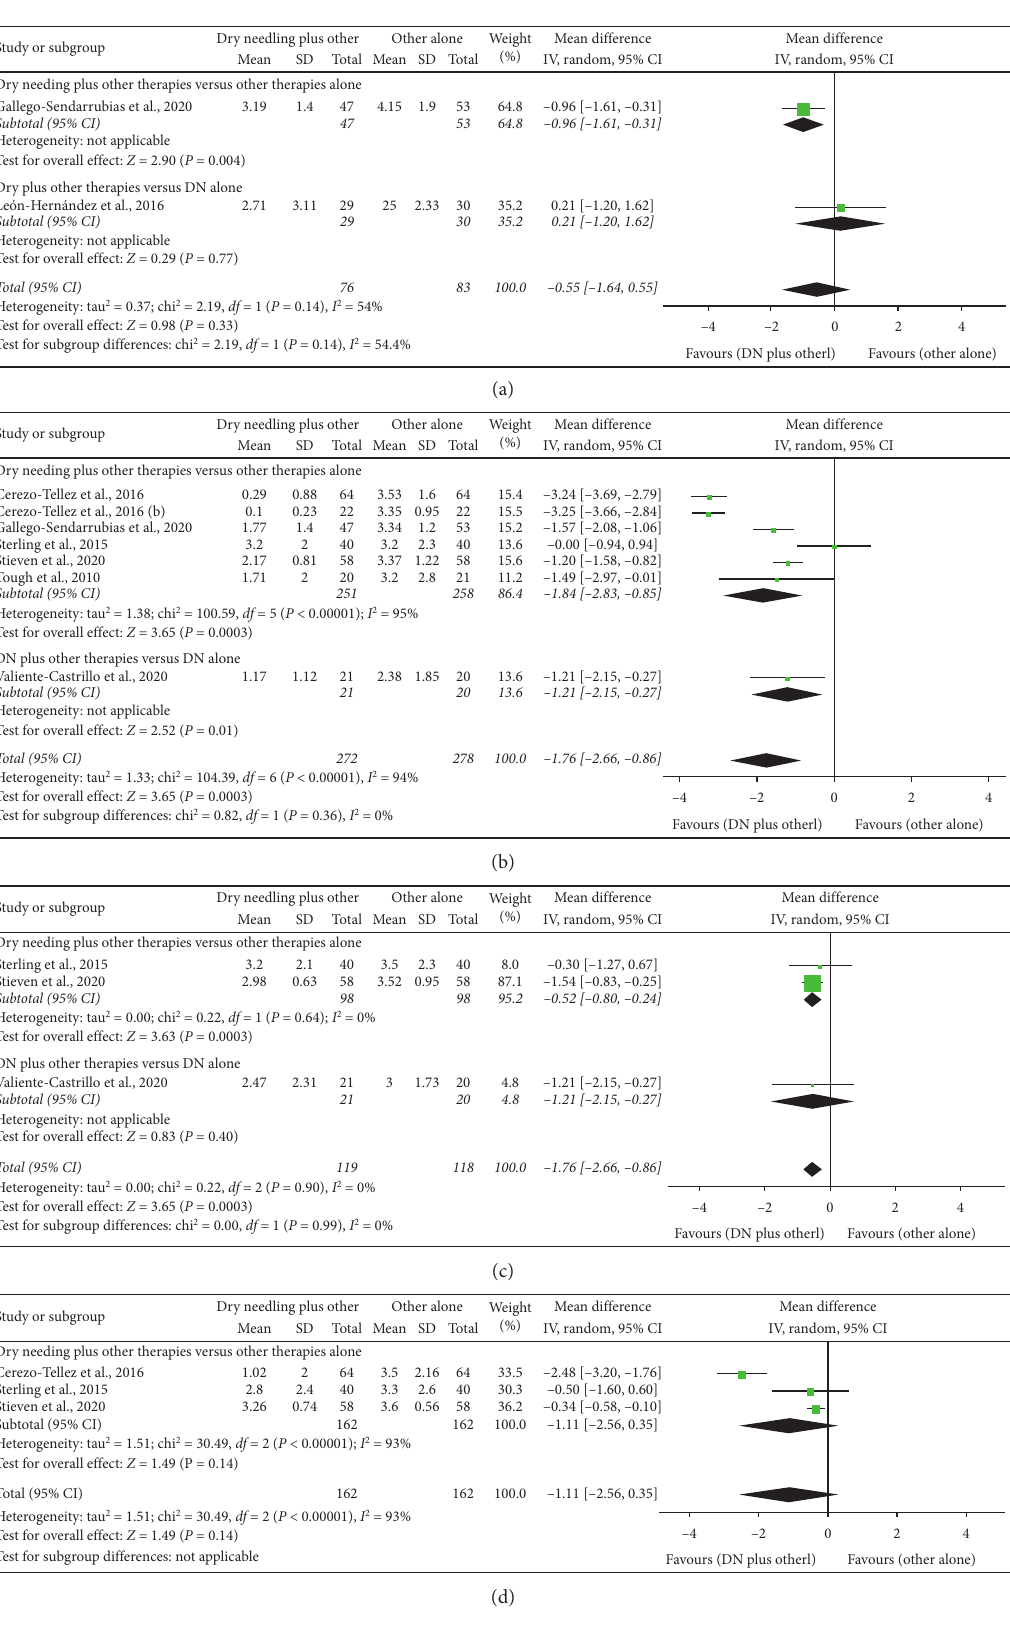
Figure 3: Comparison (mean differences) between the effects of dry needling combined with other interventions against other interventions on pain intensity (a) immediately after, (b) at short-term, (c) at midterm, and (d) at